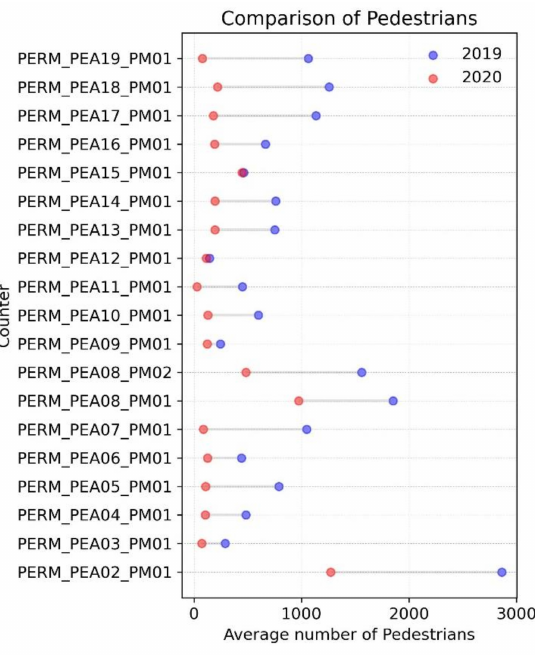
Figure 6. Change in the number of pedestrians by counter